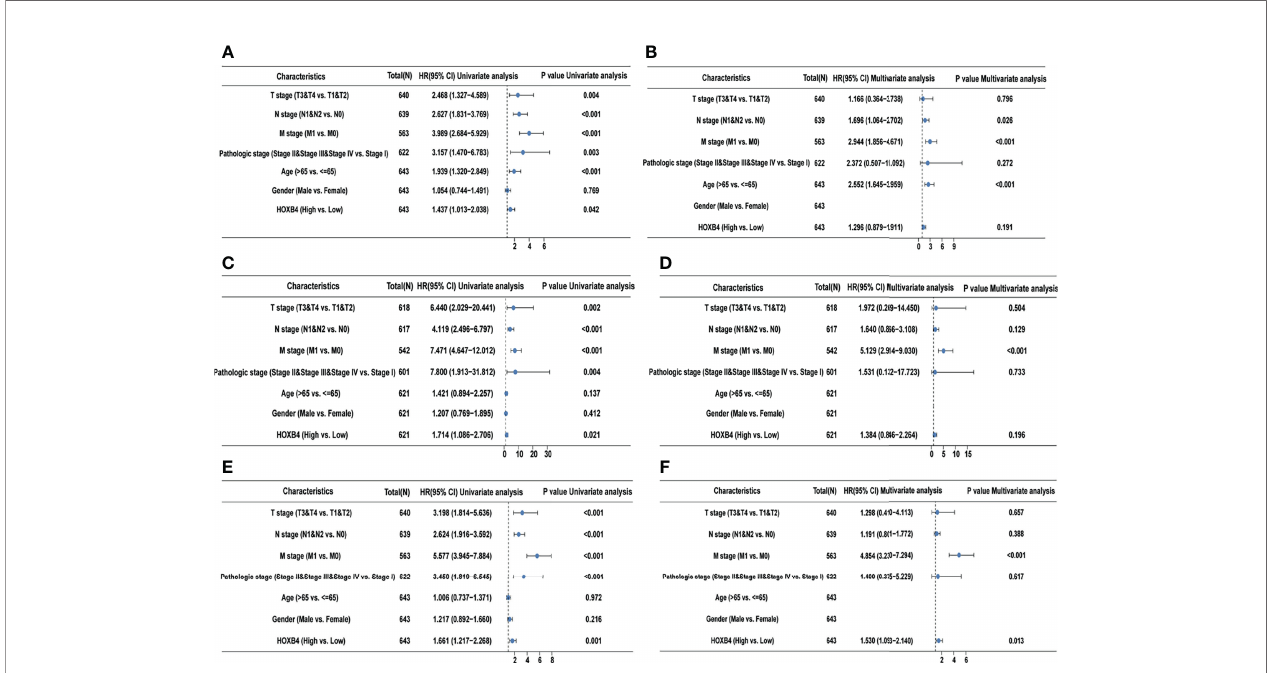
FIGURE 4 | Univariate and multivariate regression analyses of HOXB4 expression and clinicopathologic parameters with OS event, DFS event, and PFI event in COAD patients. Univariate and multivariate regression analyses of HOXB4 expression and other clinicopathologic parameters with OS event (A, B) , DFS event (C, D) and PFI event (E, F) in COAD. OS, overall survival; DFS, disease-speci fi c survival; PFI, progression free interval; COAD, colon